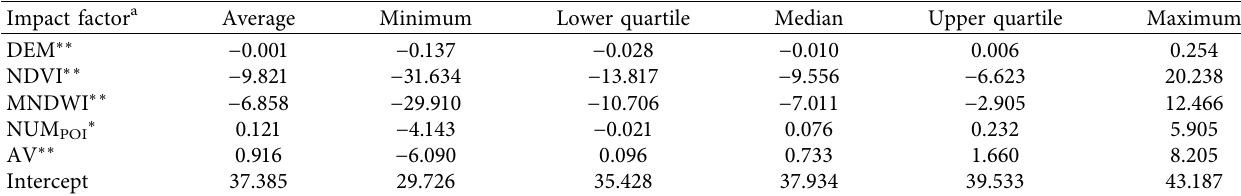
Table 7: Descriptive analysis of regression coefficients.